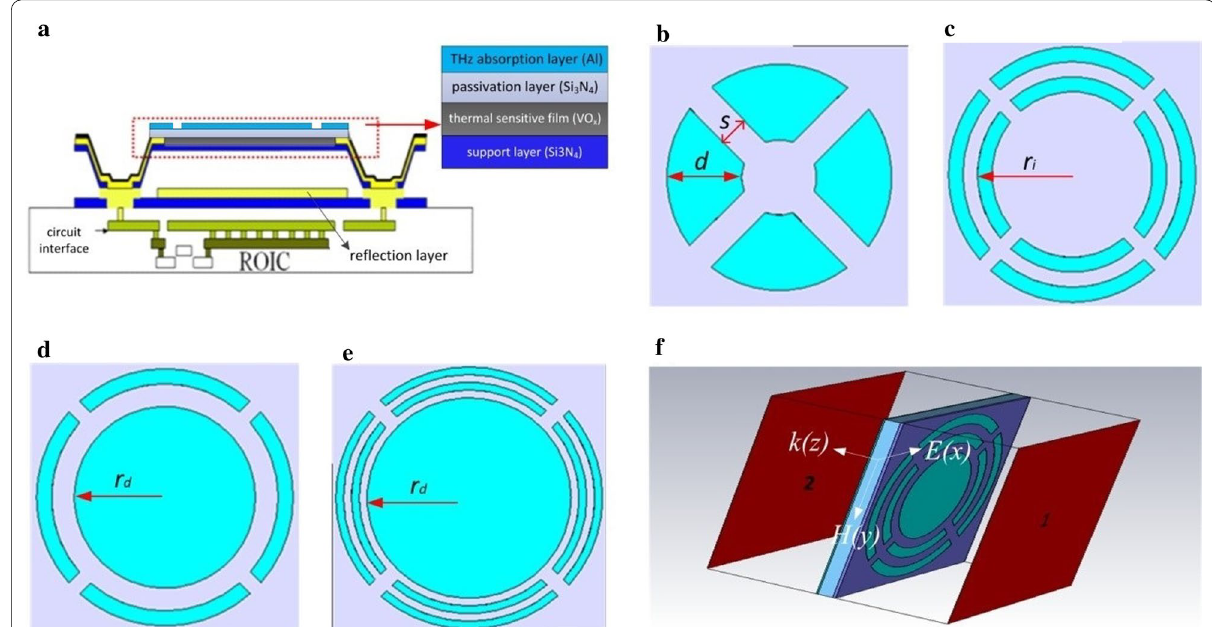
Fig. 1 Design of micro-bridge structure coupled with split-ring resonators. a Sectional view of micro-bridge structure. b Split-ring with four openings. c Dual-ring structure. d A split-ring combined with an Al disk. e Dual-ring structure combined with an Al disk. f A single unit cell of THz microbolometer array illuminated by vertical incident